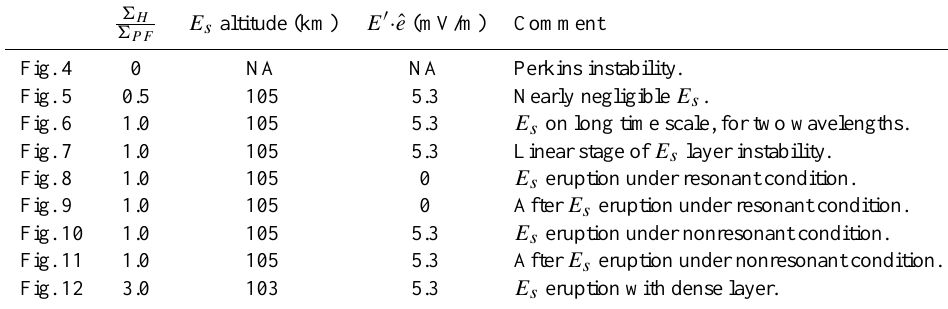
Table 1. Simulation parameters and purposes indexed by figure number.